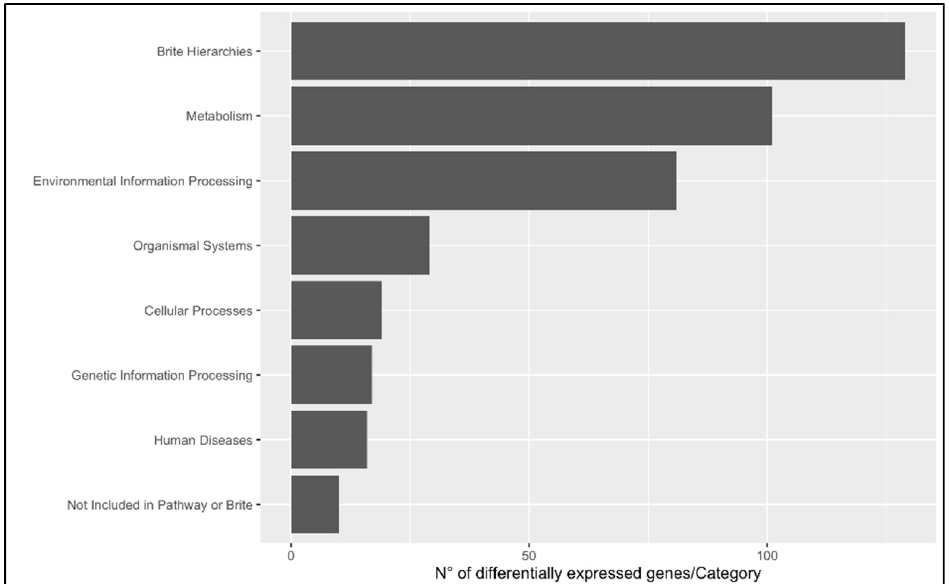
Figure 5. KEGG BRITE functional hierarchies analysis category A (macro category). The bar plot shows in x -axis the number of DEGs per macrocategory between livers of immature ( n = 3) and mature ( n = 3) females; y -axis indicates the pathway description.